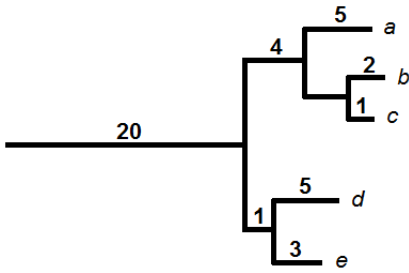
Figure 1. A hypothetical phylogenetic tree for species a through e . Branch lengths are shown above branches. The PD is 41 for this set of species (20 + 5 + 4 + 2 + 1 + 5 + 1 + 3). If species a was lost, 5 units of PD would be lost. Successive losses of species would imply PD losses of similar magnitude. However, the loss of the last species of the clade would imply that the deeper branch of 20 units is now lost as